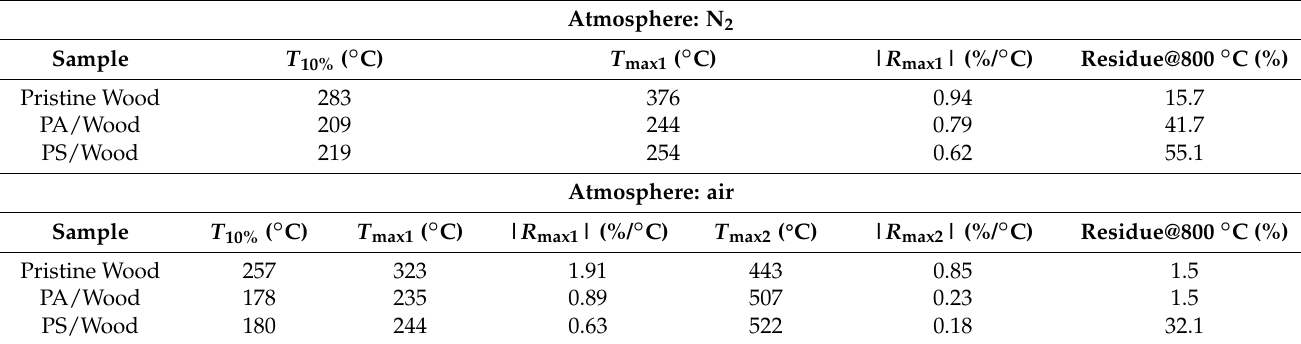
Figure 7. TG and DTG curves of the wood samples in nitrogen and in air. Table 3. Relevant data from the TG and DTG curves in nitrogen and